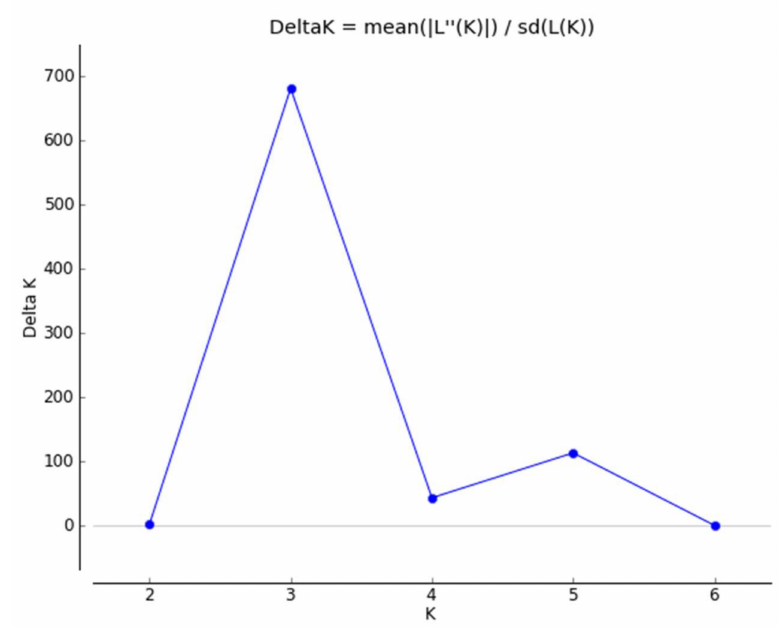
Figure 2. The model choice for each K value and graphical results of the SRUCTURE analysis.